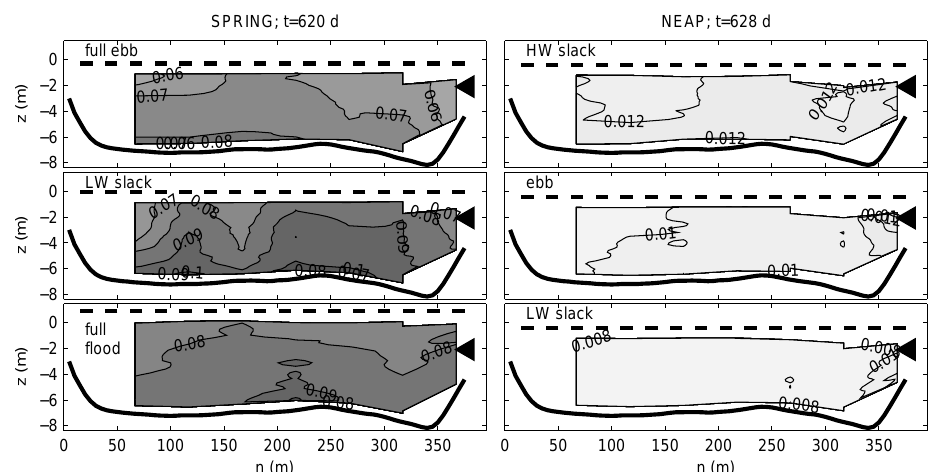
Fig. 6. Suspended sediment concentration from optical measurements (kgm − 3 ) in the cross-section close to Gunung Tabur at three phases in a tidal cycle during spring tide (left) and during neap tide (right). The black triangle indicates the position of the HADCP.